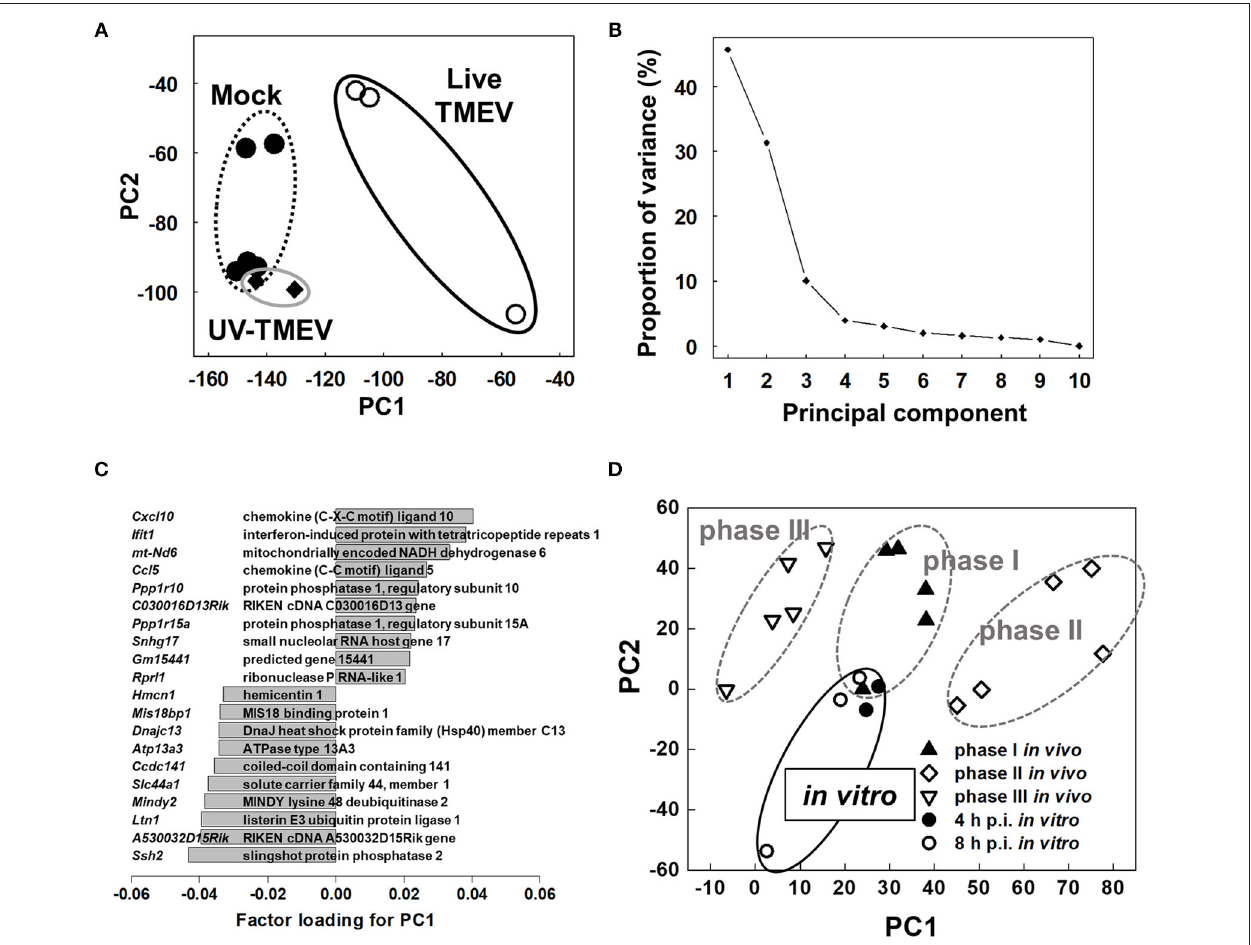
FIGURE 4 | Unsupervised principal component analysis (PCA) of transcriptome data of mock-infected, TMEV-infected, and UV-TMEV-incubated HL-1 cells (33, 42). (A) PCA separated samples into two groups: TMEV-infected samples vs. uninfected samples (mock infection and UV-TMEV), where principal component (PC) 1 reflected live virus infection. (B) The proportion of variance showed that PC1 explained 46% of the variance among the samples. (C) Factor loading for PC1 showed that chemokines ( Cxcl10 and Ccl5 ) and interferon-inducible genes ( Ifit1 ) were correlated with PC1 positively, while several genes including slingshot protein phosphatase 2 (Ssh2) and listerin E3 ubiquitin protein ligase 1 ( Ltn1 ) were correlated with PC1 negatively. (D) PCA of transcriptome data of TMEV-infected HL-1 cells 4 and 8h p.i. and heart samples from phases I (4 days p.i.), II (7 days p.i.), and III (60 days p.i.) in TMEV-induced myocarditis in vivo . PCA showed that phase I samples and in vitro samples had similar PC1 values, compared with phases II and III samples. PCA was conducted using R version 3.4.3 ( 13). Microarray data were converted into tab-delimited text format and calculated using an R program